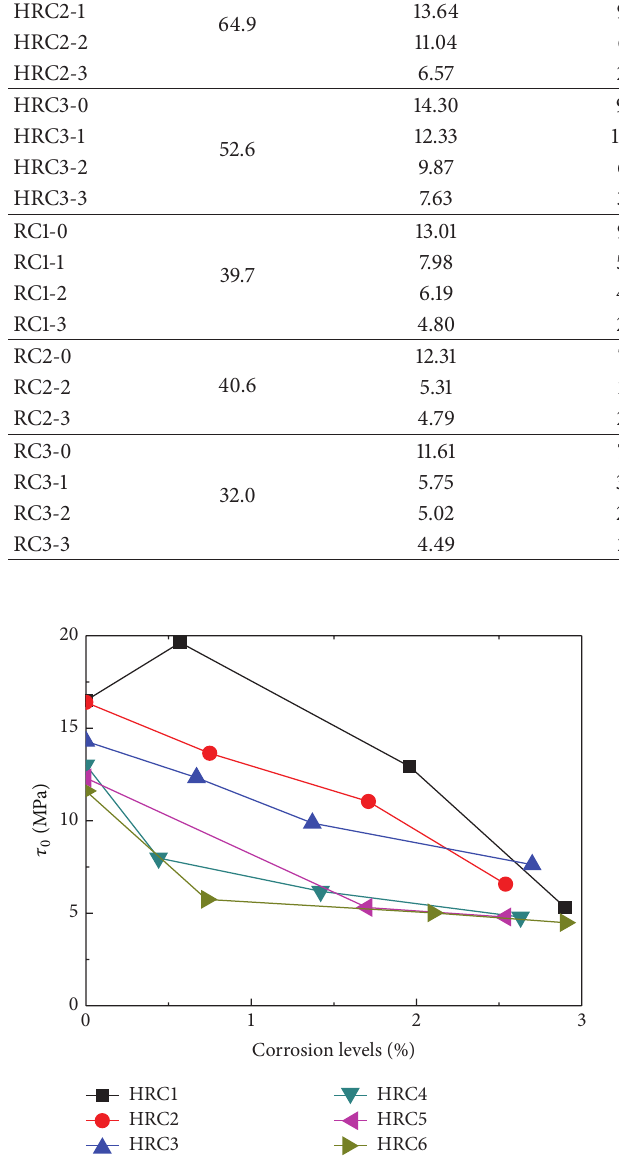
Figure 5: 𝜏 0 versus corrosion